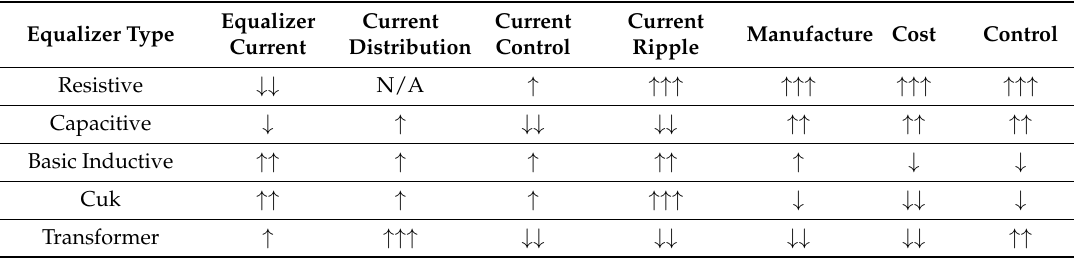
Table 9. Comparison of equalizers; a ↑ sign indicates an advantage whereas the ↓ signs indicate drawbacks. Adapted from